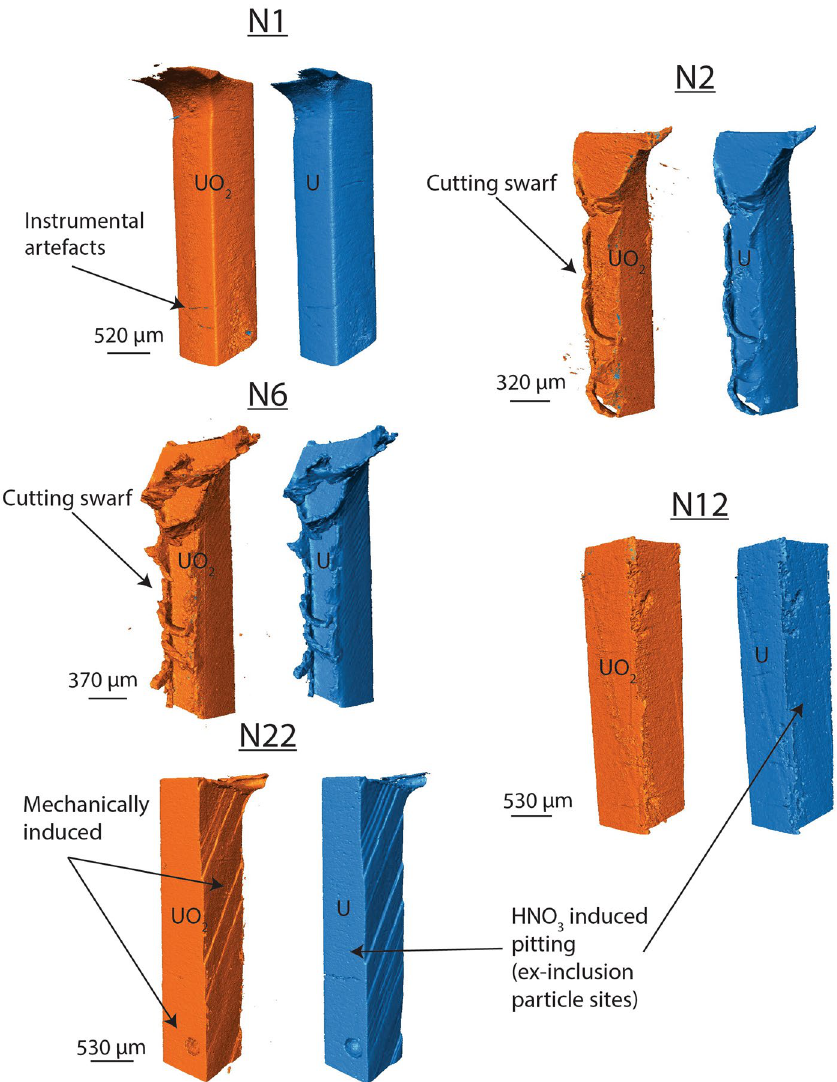
Figure 3. 3D renders of the nitric acid etched samples. The corrosion products are exhibited in orange (left) and the uranium in blue